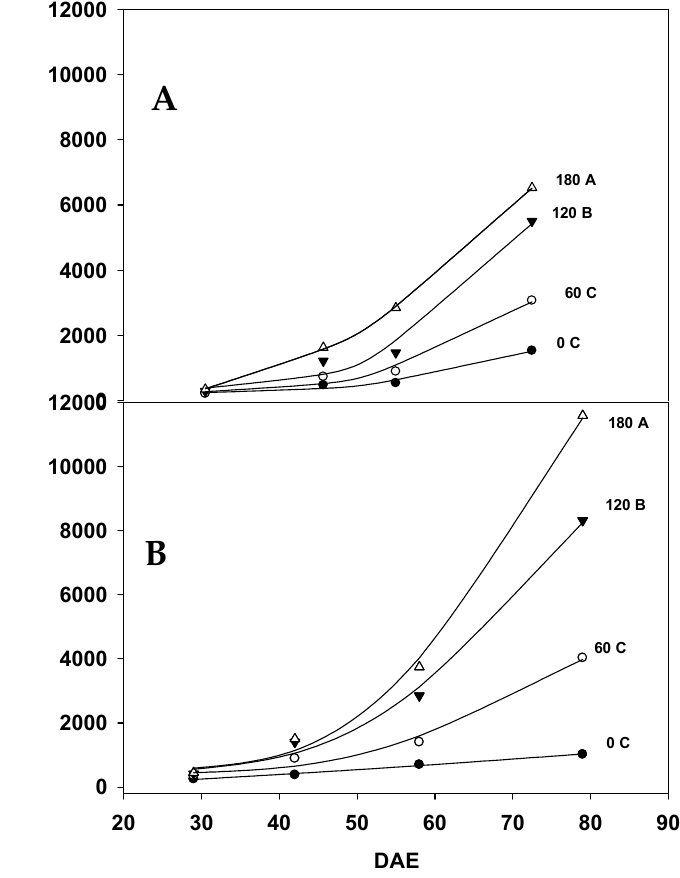
Figure 7. Accumulation of dry matter vs. days after emergence (DAE) for ( A ) early-ripening cv. Zahir and ( B ) late-ripening cv. Ruta during growth. Different uppercase letters indicate significant differences at p < 0.01. The numbers inside the graph indicate applied pure N in kg ha − 1 , equivalent to 0–18 N units.